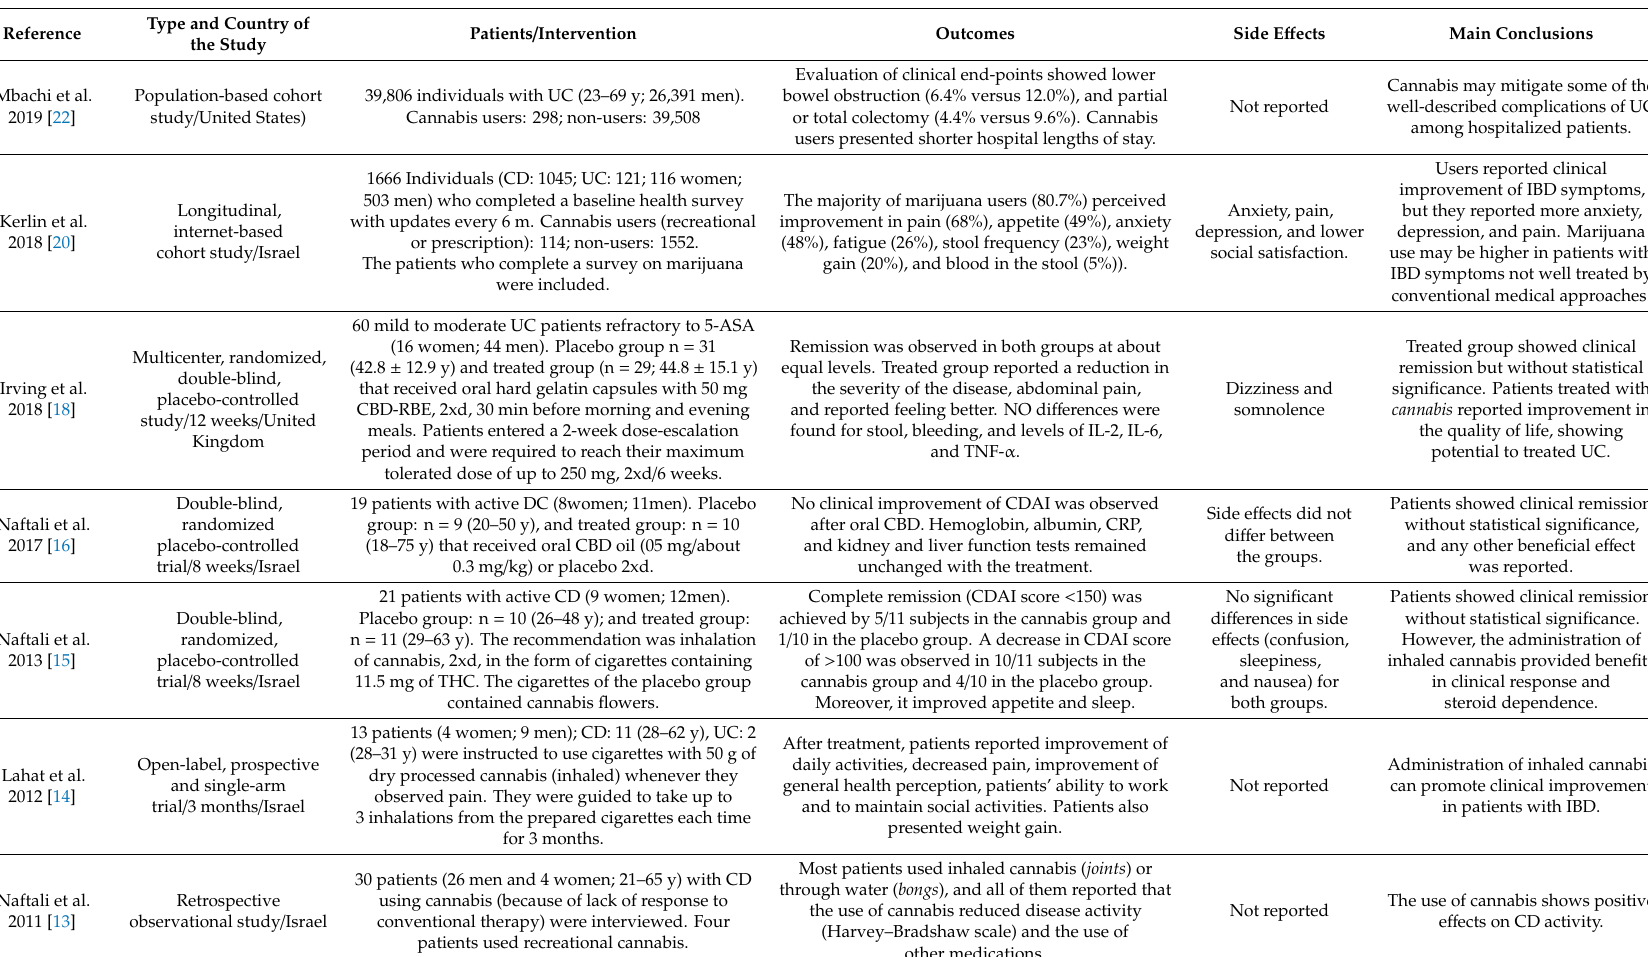
Table 1. Main characteristics of the studies included in the